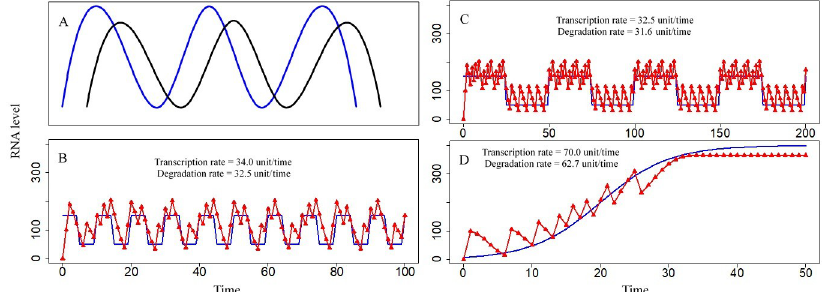
Fig 3. Environmental variations influencing RNA level fluctuations. Blue line represents the demand for RNA activity (DRA). Black curve represents total levels of RNA (TR). Red curve represents total RNA activity (TRA), and triangles on the curve are predicted values. The x-axis is time, and the unit of time is RNA age, which is standardized as unitless values. The y-axis is the RNA level, which is standardized as unitless values. (A) Validation data: RNA level fluctuations with oscillatory environmental levels reported in the literature [12] and RNA level fluctuations with irregular environmental effects shown in Figs 1C [37] and S1C [21]. (B) Differences in the cycle lengths of TR and DRA. TR and TRA curves overlap (DRA is rotated between 50 for 5 RNA ages and 150 for 5 RNA ages. If TRA < DRA, then RNA level at age 0 = 100; otherwise, RNA level at age 0 = 0. The survival rate decreases at older RNA ages, i.e., the type B RNA survival rate is shown in S2 Table. The RNA activity coefficient of each RNA age is 1, i.e., the type A RNA activity coefficient in S2 Table). (C) Similarity in the cycle lengths of TR and DRA, with local sub-cycles within the global cycles. TR and TRA curves overlap (DRA is rotated between 50 for 25 RNA ages and 150 for 25 RNA ages. If TRA < DRA, then RNA level at age 0 = 100; otherwise, RNA level at age 0 = 0. The survival rate decreases at older RNA ages, i.e., the type B RNA survival rate is shown in S2 Table. The RNA activity coefficient of each RNA age is 1, i.e., the type A RNA activity coefficient in S2 Table). (D) Aperiodic DRA. TR and TRA curves overlap (DRA is a logistic function: DRA = 400/(1+e 4-0.2 × time ). If TRA < DRA, then RNA level at age 0 = 100; otherwise, RNA level at age 0 = 0. The survival rate decreases at older RNA ages, i.e., the type B RNA survival rate is shown in S2 Table. The RNA activity coefficient of each RNA age is 1, i.e., the type A RNA activity coefficient in S2 Table).